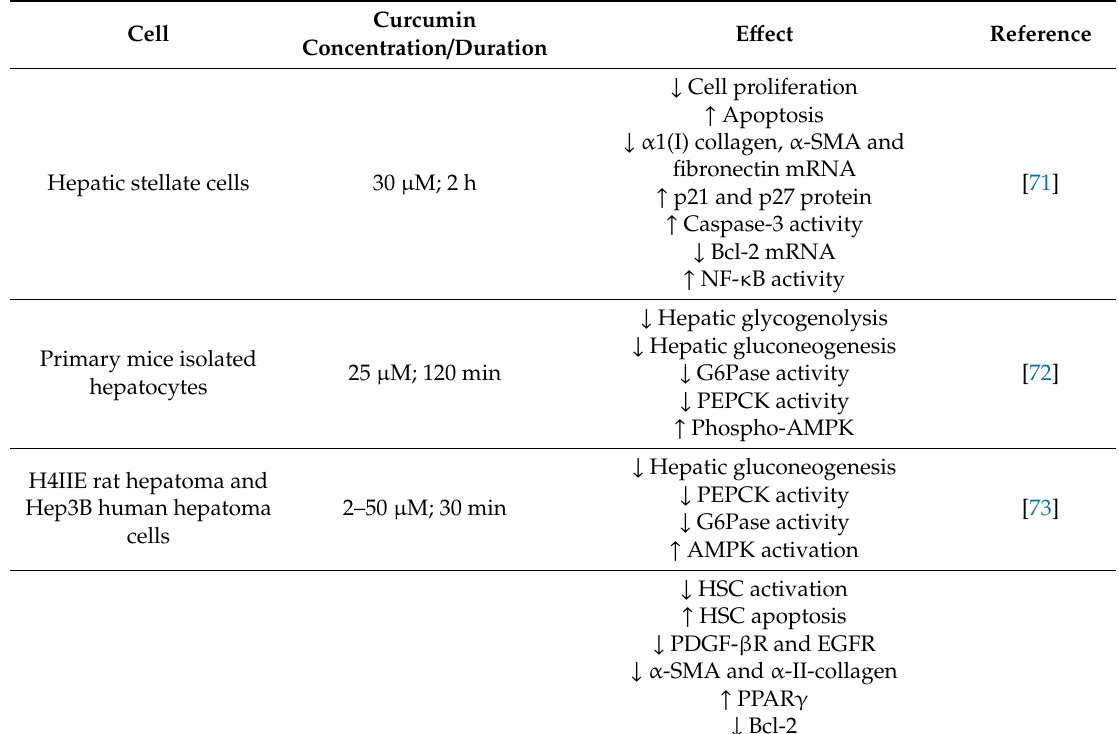
Table 2. E ff ects of curcumin: in vitro hepatocyte